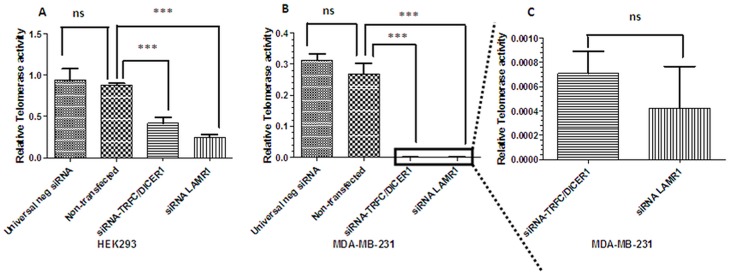
Effect of LRP/LR on telomerase activity in HEK293 and MDA_MB231 cells.The expression level in HEK293 and MDA_MB231 cells was investigated using TRAPEZE Telomerase kit (Merck Millipore) and qPCR. Analysis of the concentrations revealed a significant (*** p < 0.001) reduction in telomerase activity once LRP was knockdown in A) HEK293, B) and C) MDA_MB231 cells, respectively, compared to control non-transfected cells and negative control siRNA transfected cells. Non-significant (ns) at p>0.05.